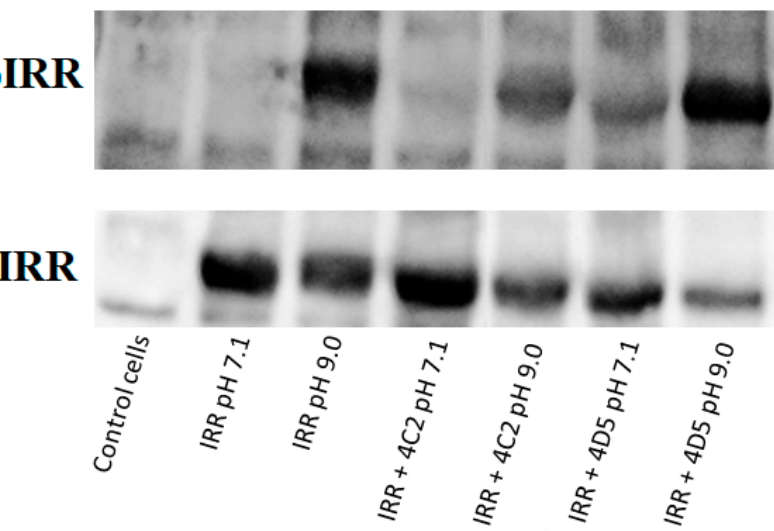
Figure 4. Influence of 4D5 and 4C2 antibodies (90 µg/mL) on IRR activation at neutral and alkaline pH.